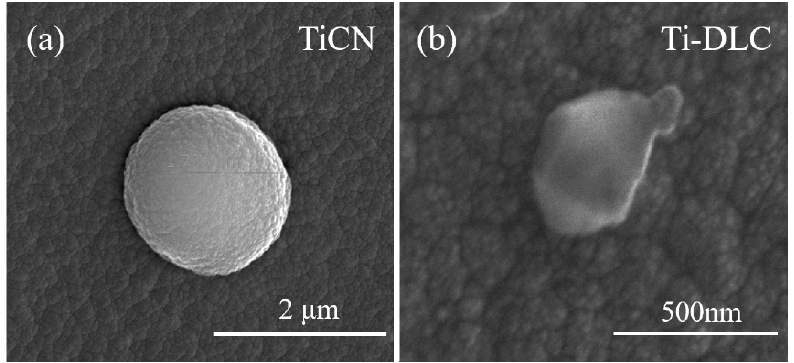
Figure 2. SEM images showing the morphology of TiC particles in the films of ( a ) TiCN and ( b ) Ti-DLC.